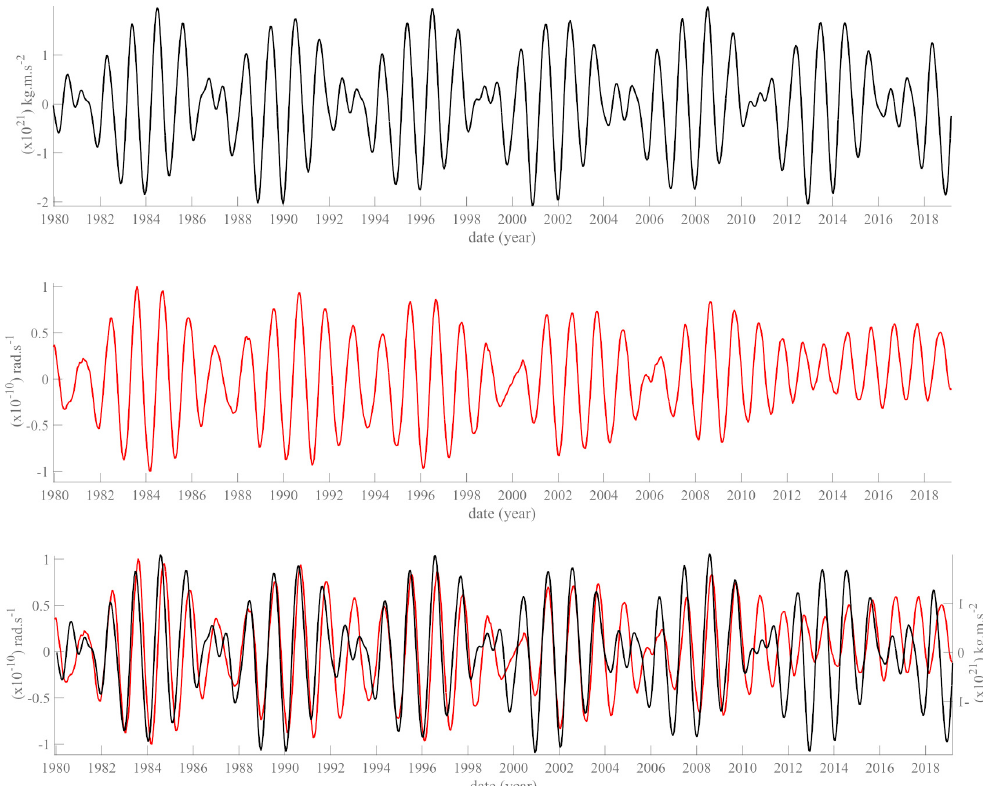
Figure 6. Top curve (in black): the sum of the forces of the four Jovian planets affecting Earth (ephemerids from the IMCCE ). Middle curve (in red): the m 1 component of polar motion (1980–2019), reconstructed with SSA and with the trend (Markowitz) removed. Bottom: superposition of the 2 curves. From Lopes et al. [7], Figure